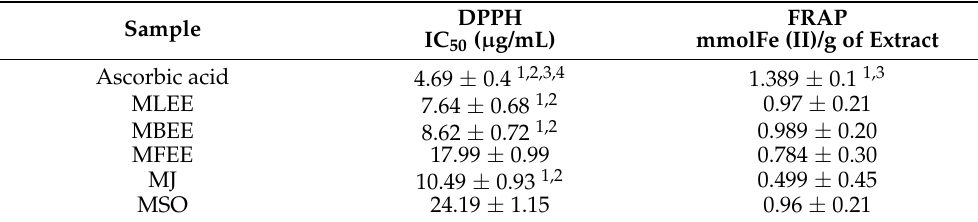
Figure 2. HPLC chromatograms of investigated black mulberry tree bark ethanol extract and phenolic compounds identified (the numbers refer to corresponding peaks, presented in Table 1): chlorogenic acid (1), vanillic acid (2), p-coumaric acid (3), isoquercetin (6), ellagic acid (7), kaempferol-3-O-glucoside (8), morin (10), quercetin (12), luteolin, (13) kaempferol (14) and gallic acid (15). Table 4. Percentage of DPPH inhibitory values and IC50 values and FRAP antioxidant capacity of black mulberry leaf ethanol extract, black mulberry bark ethanol extract, black mulberry juice, black mulberry fruit ethanol extract and black mulberry seed oil (mean of measurements performed in triplicate ±